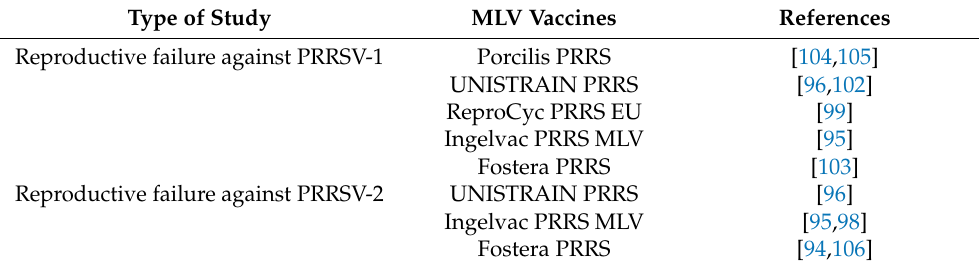
Table 3. Efficacy of PRRS MLV vaccines against reproductive failure in gilts and